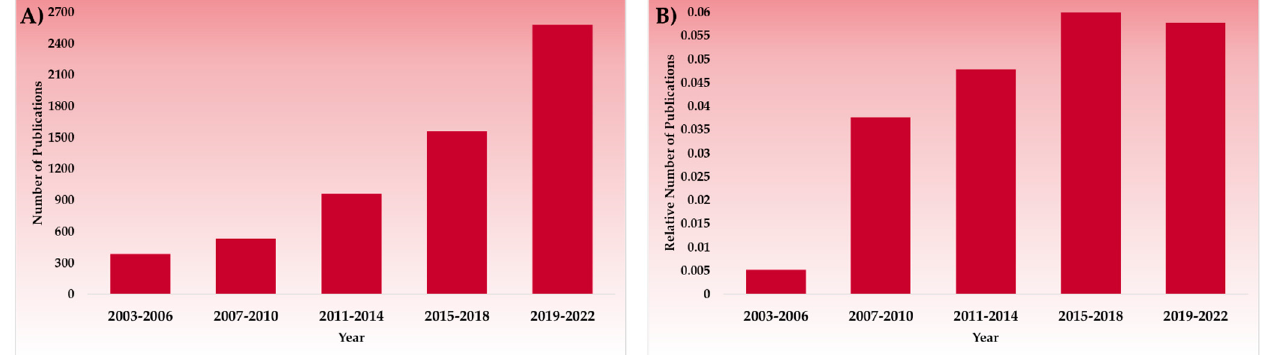
Figure 2. Trends of scientific publications from 2003 to 2022 for ( A ) Drug stability, hygroscopicity, ( B ) Co-crystals, drug stability, hygroscopicity. Data taken from Science Direct.